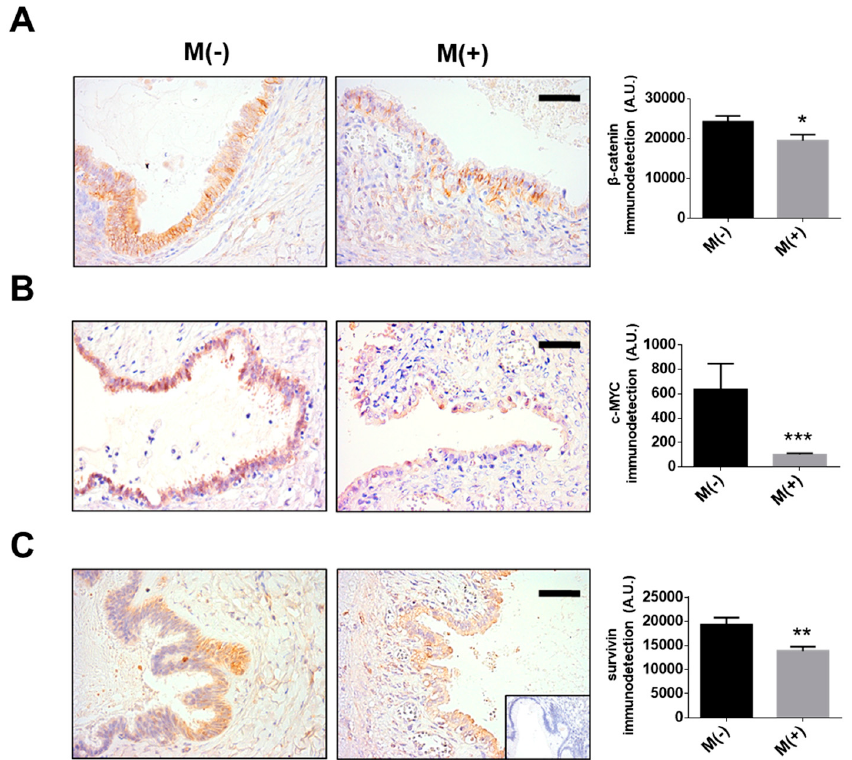
Figure 6. Metformin intake decreases the presence of β -catenin, c-MYC and survivin in epithelial ovarian tumours. Sequential paraffin-embedded samples from female users (M+) and non-users (M − ) of metformin were used to detect oncoproteins by immunohistochemistry: β -catenin ( A ) c-MYC ( B ), or survivin ( C ) levels. N = 4 independent experiments (6–8 images were evaluated per experiment). Bar = 40 µm. * p < 0.05; ** p < 0.01 and *** p < 0.001 according to the Mann–Whitney test. Results are expressed as the mean ± standard error of the mean (SEM).